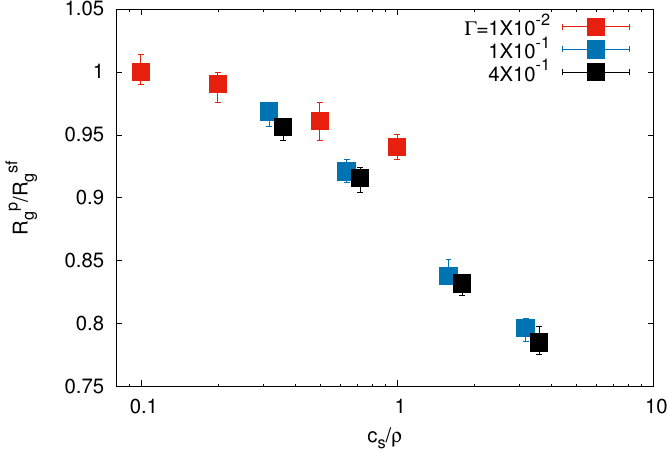
Figure 5. Dependence of the average radius of gyration of individual polymers R p g on the ratio of the salt concentration c s and network charge density ρ for N c = 147 and L / l = 200. R sf g is the polymer radius of gyration of the salt-free